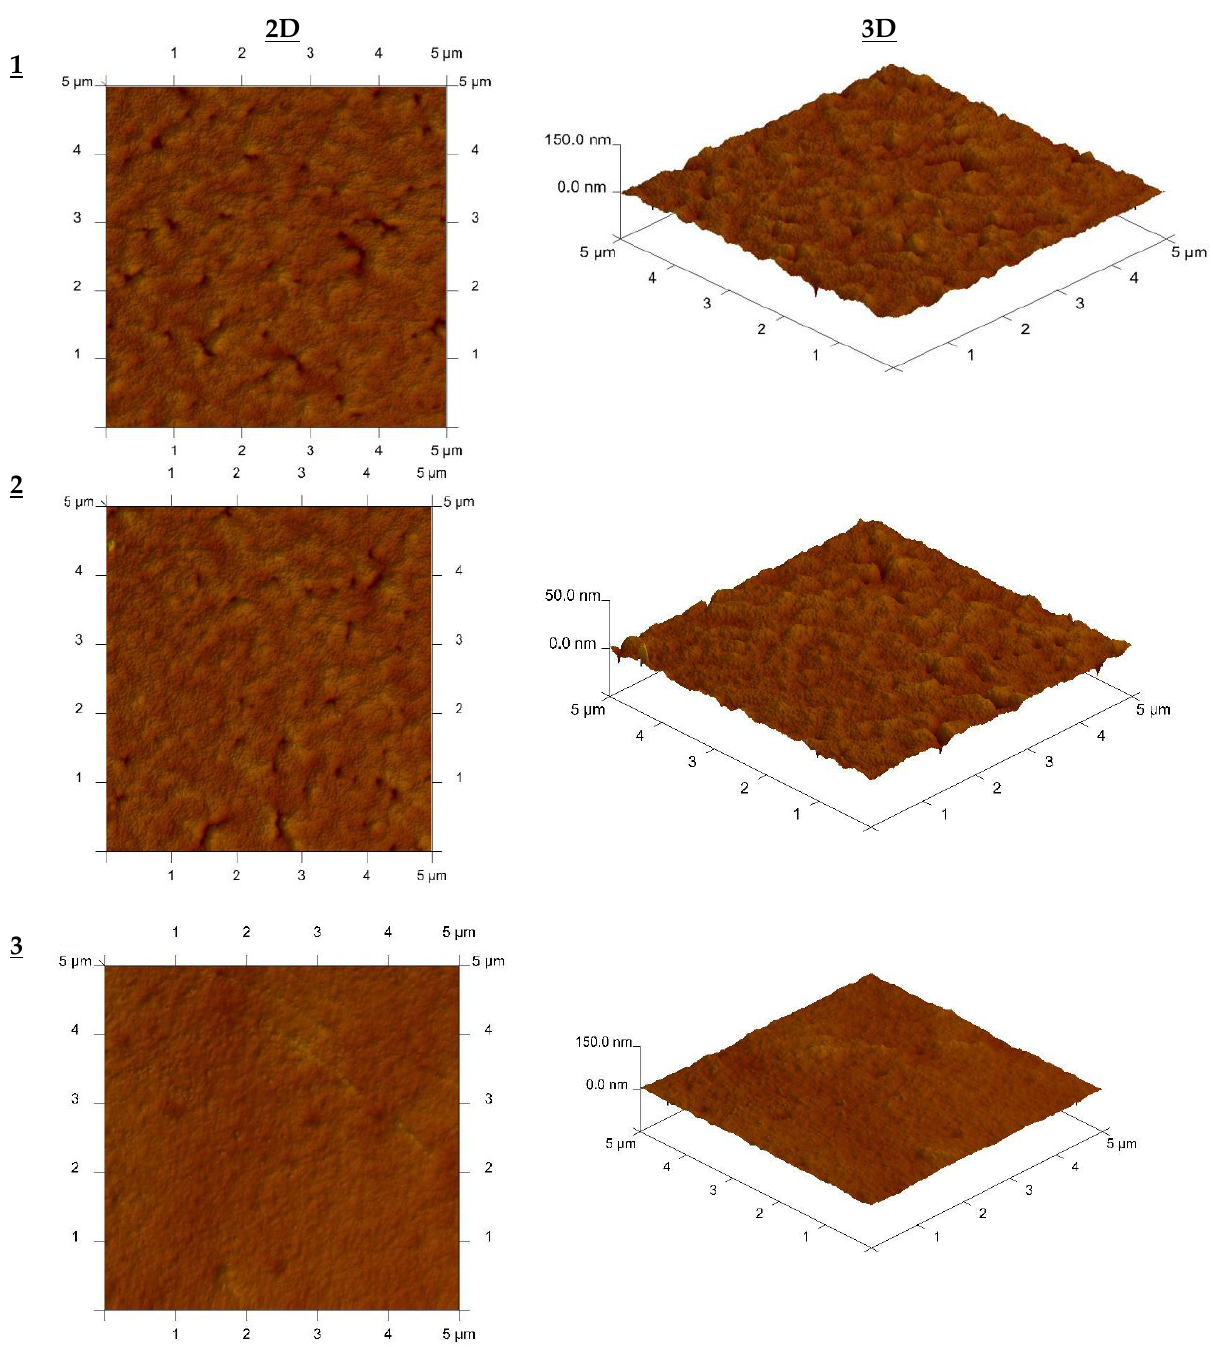
Figure 1. AFM pictures of the PIMs with 1-alkyltriazole; 1 – 1-hexyltriazole, 2 – 1-octyltriazole, 3 – 1-decyltriazole.